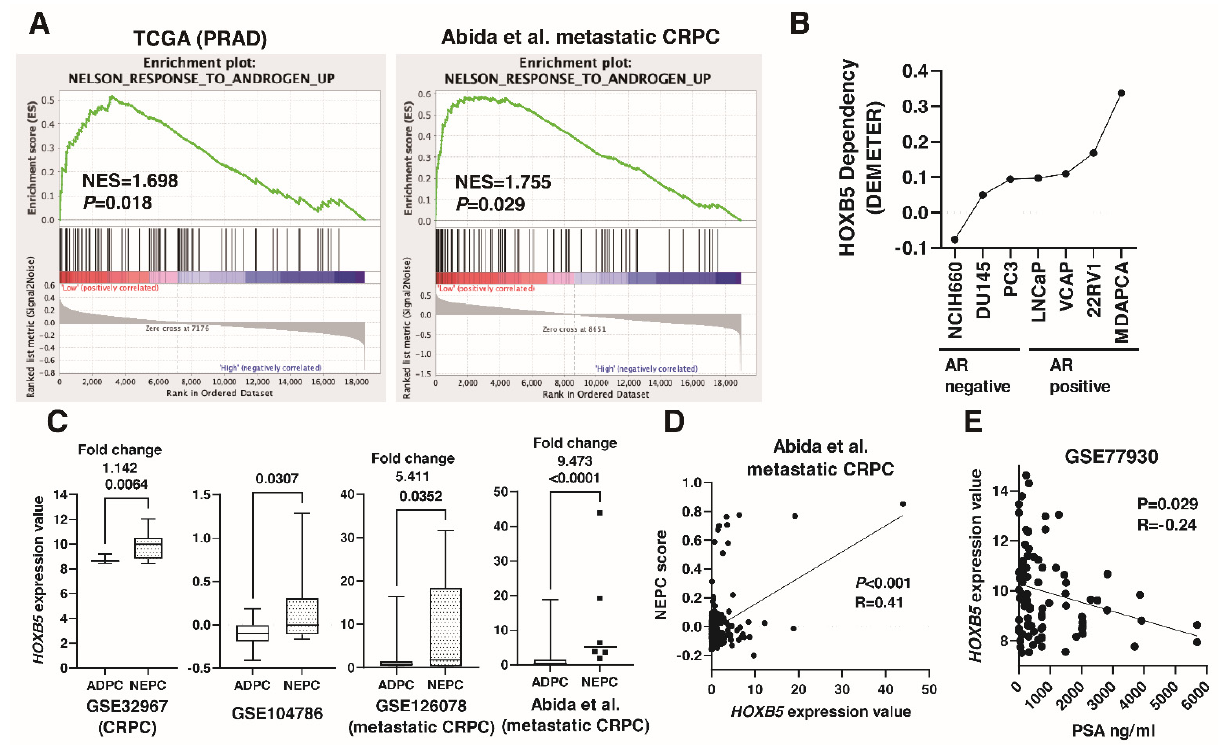
Figure 5. The involvement of HOXB5 in neuroendocrine differentiation in prostate cancer (PCa). ( A ) GSEA for genes differentially expressed in the low HOXB5 expression group compared to the high HOXB5 expression group using Nelson androgen response gene sets in TCGA (PRAD) and the study by Abida et al. ( B ) Relative HOXB5 dependency scores (DEMETER) reflect the ability of PCa cell lines to maintain proliferation after HOXB5 knockdown taken from Project Achilles 2.201. ( C ) Box plot of HOXB5 expression in ADPC and NEPC in GSE32967, GSE104786, GSE126078, and the study by Abida et al. Fold changes are indicated. ( D ) The correlation between HOXB5 expression and NEPC score in the study by Abida et al. Spearman’s correlation coefficients and p -values are indicated. ( E ) The correlation between HOXB5 expression and PSA expression in GSE77930. Spearman’s correlation coefficients and p -values are indicated.